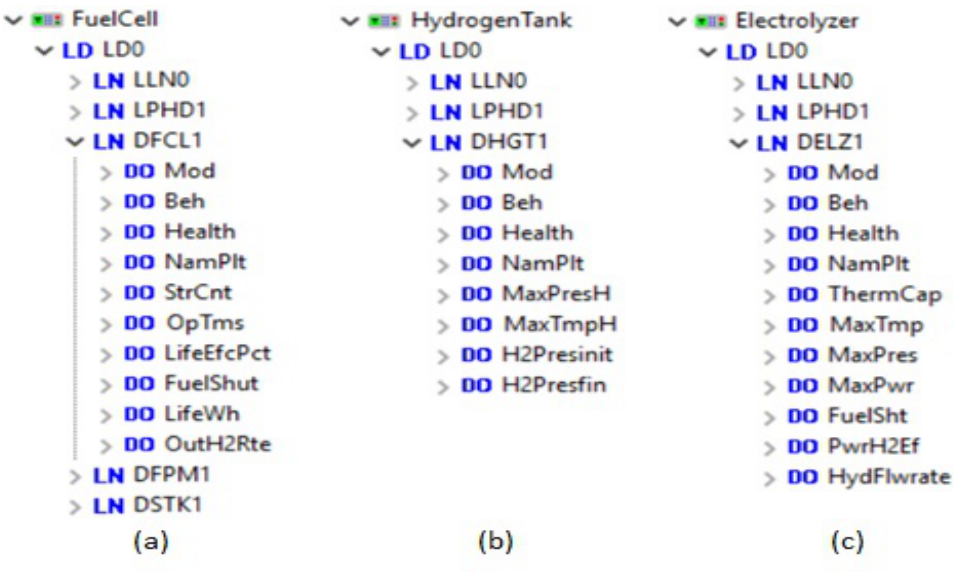
Figure 10. IEC 61850 SCL file for ( a ) fuel cell, ( b ) hydrogen tank and ( c ) electrolyzer. Table 8. IEC 61850 message exchanges during energy management in FC-PV hybrid